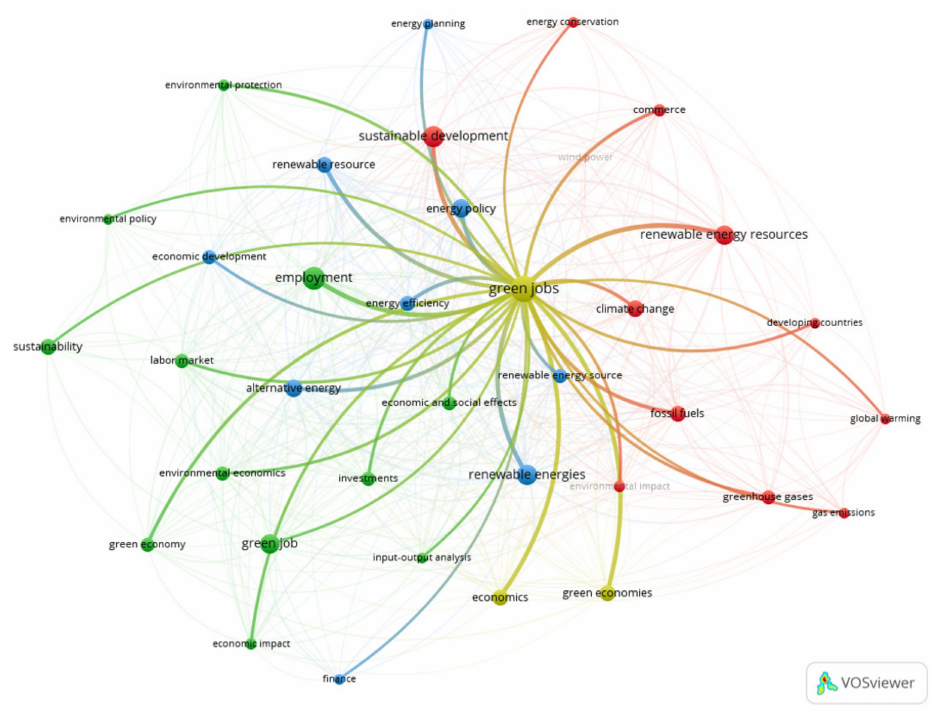
Figure 9. Keyword “green jobs” relations with other keywords. Source: Authors’ elaboration in VOSviewer software (1.6.18 version).